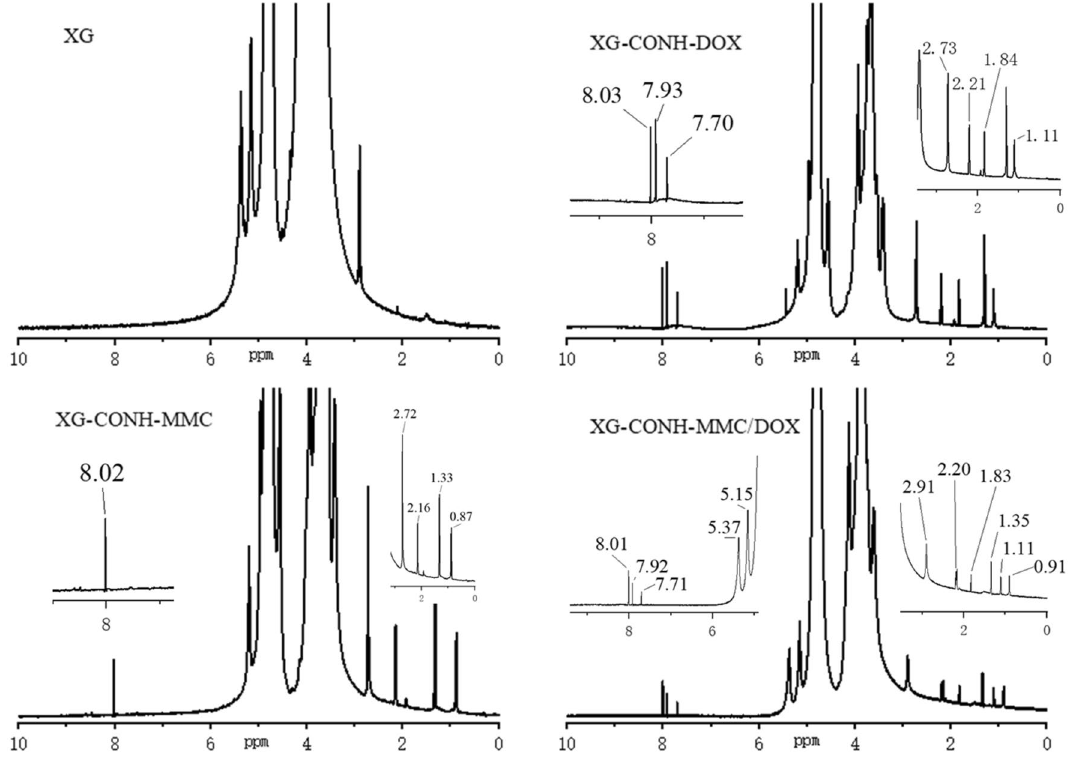
Figure 2. 1 H NMR spectroscopy of xyloglucan (XG), XG-CONH-DOX, XG-CONH-MMC, and XG-CONH -MMC/DOX